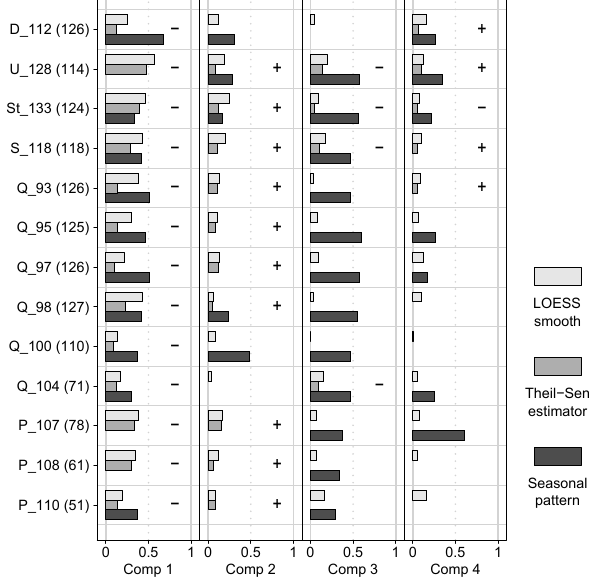
Figure 7. (a) Time series of scores of the first component at site Q_93 ( N = 126) in black and the seasonal pattern estimated with Lomb–Scargle in grey. (b) The de-seasonalized series in black and the non-linear trend estimated with LOESS in grey.